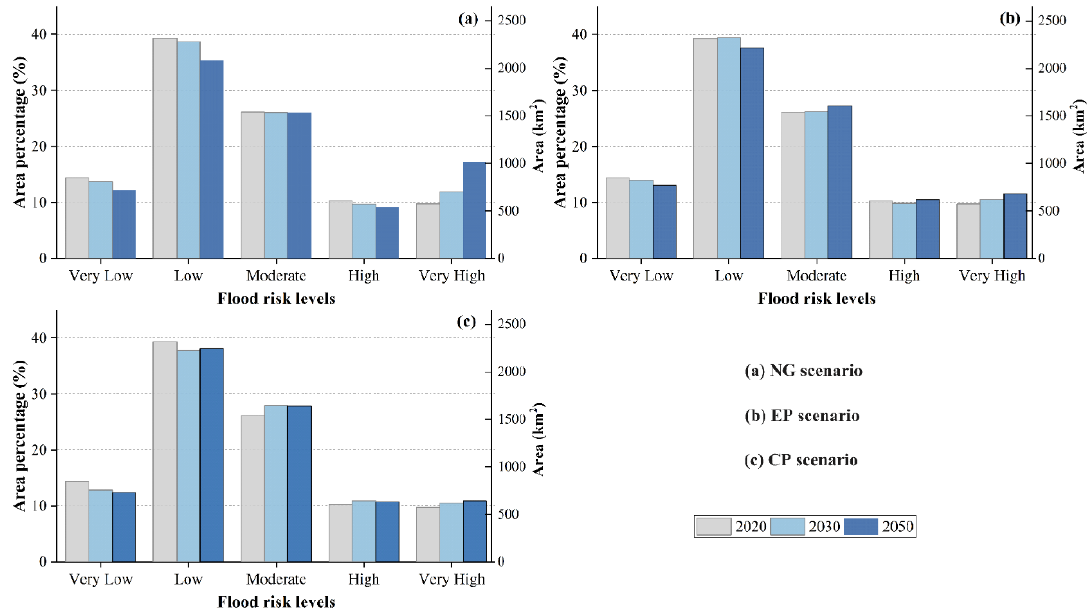
Figure 9. Changes of future flood risk under the natural growth scenario (NG), cropland protectable 2030 to 2050 in Jinjiang Basin.